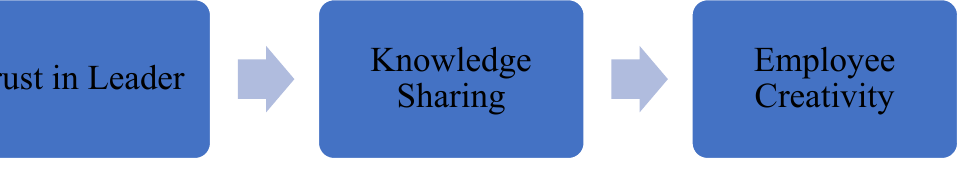
Figure 1. Conceptual model.